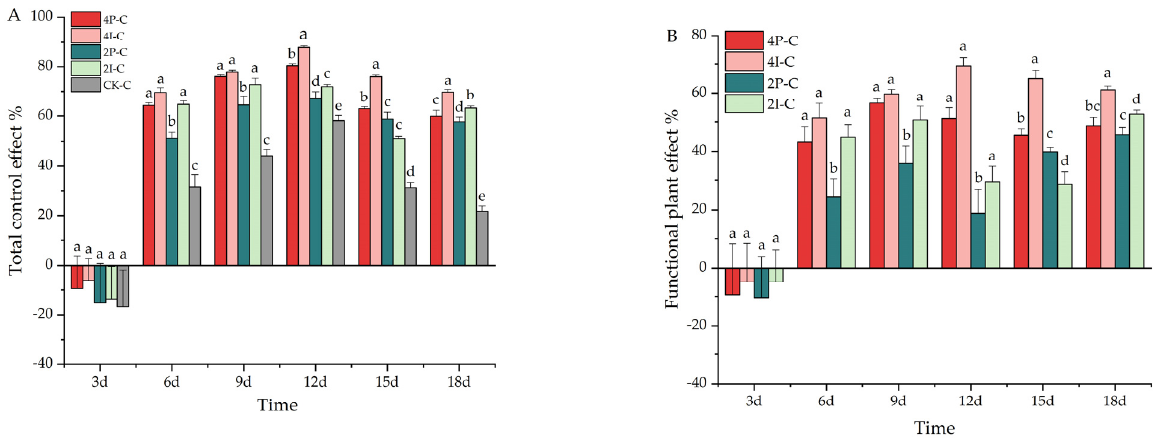
Figure 6. The percentage of aphid control and the relative effect of establishing basil functional plants. ( A ) Total control effect; ( B ) functional plant effect. The bar charts show mean ± SE values. Different letters above a given bar reveal statistically significant differences between treatments ( p <